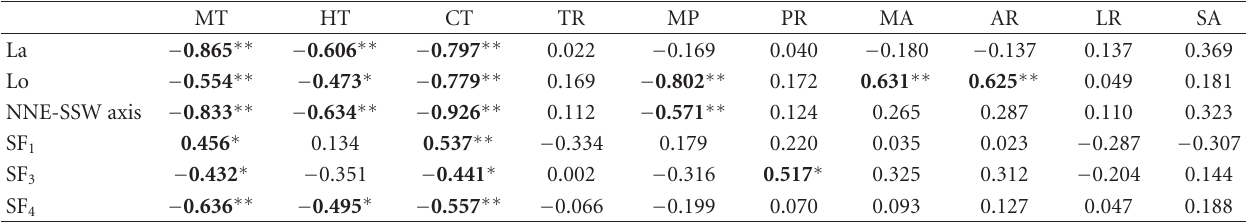
Table 4: Pearson’s coe ffi cients measuring the correlation of the environmental variables with the geographical and spatial